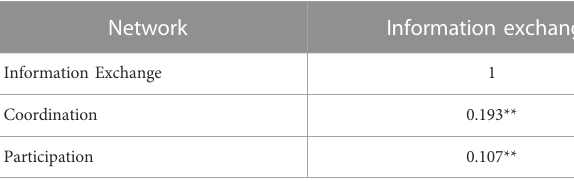
TABLE 8 Correlation of studied networks in terms of QAP